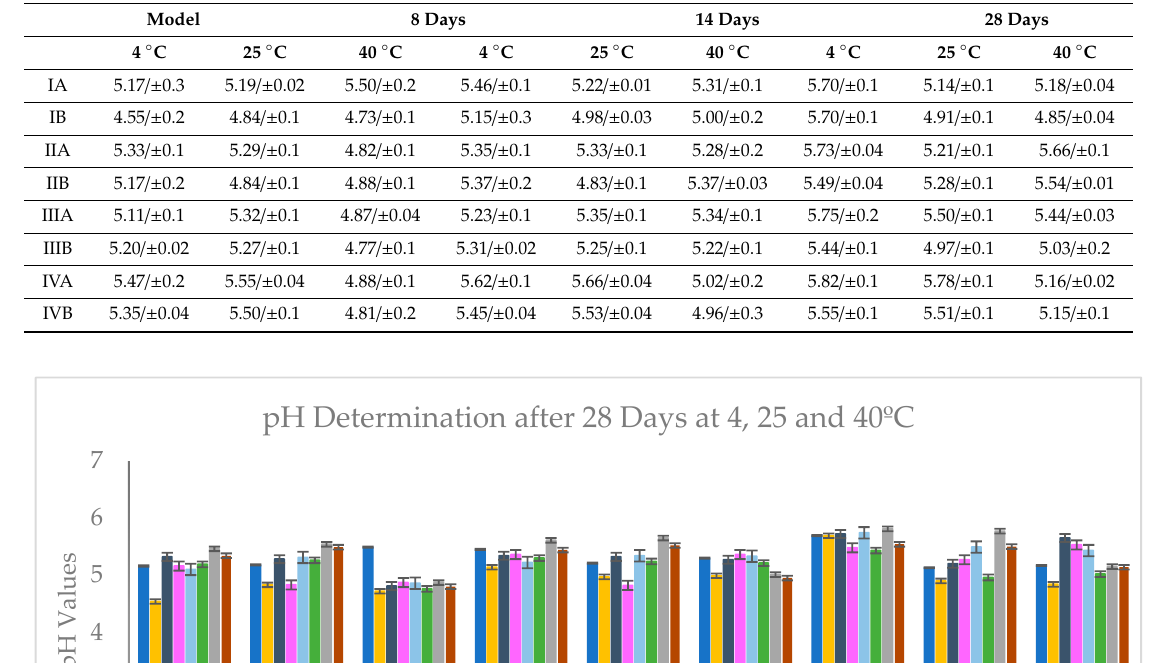
Table 1. Mean pH and standard deviation values after 8, 14, 28 days measurements for each product stored at 4 ◦ C, 25 ◦ C and 40 ◦ C.